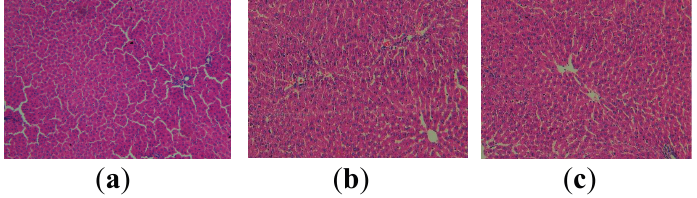
Figure 1. Histopathological evaluation of the liver tissue for the control groups.